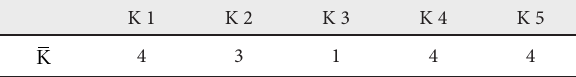
Results of the average significance level of the PMIS